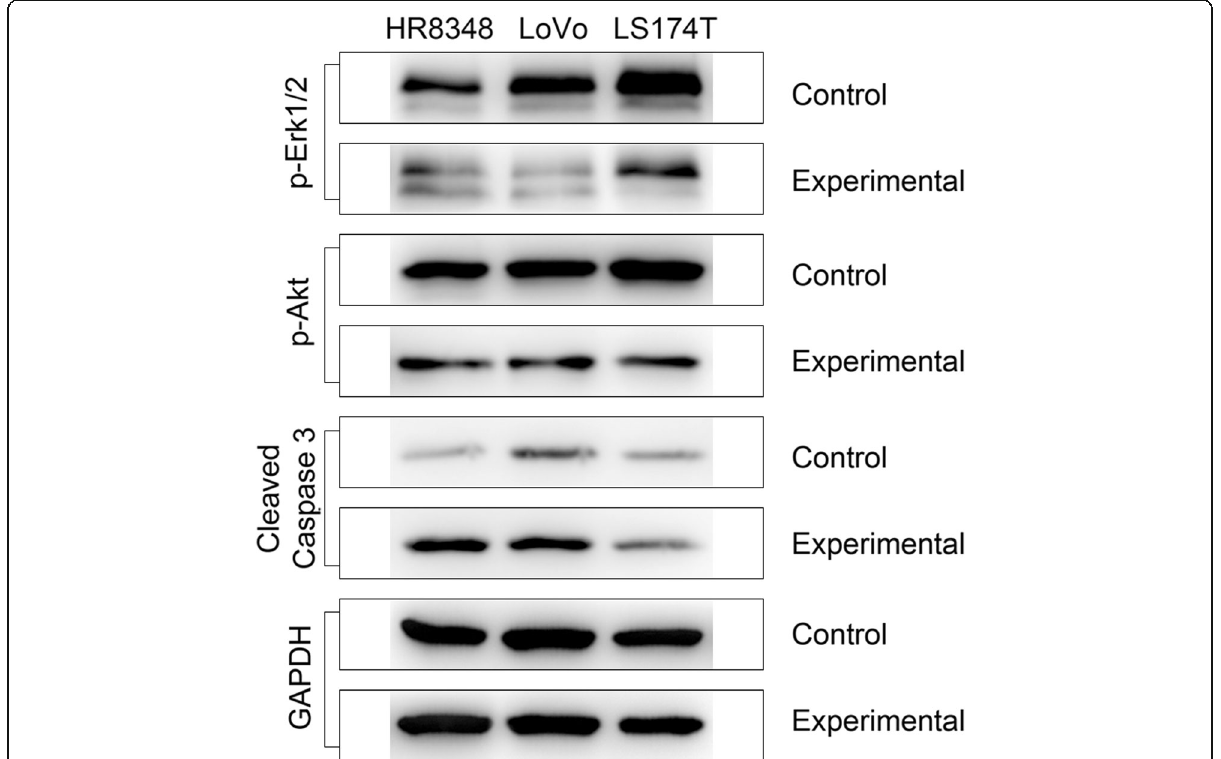
Fig. 4 Analyses of apoptosis-related proteins in HR8348, LoVo, and LS174T cells by Western blotting. The cells were treated with the IC 50 of chebulinic acid for 48 h. Phosphorylated ERK and AKT and cleaved caspase-3 were detected using the corresponding antibodies. GAPDH was used as a loading